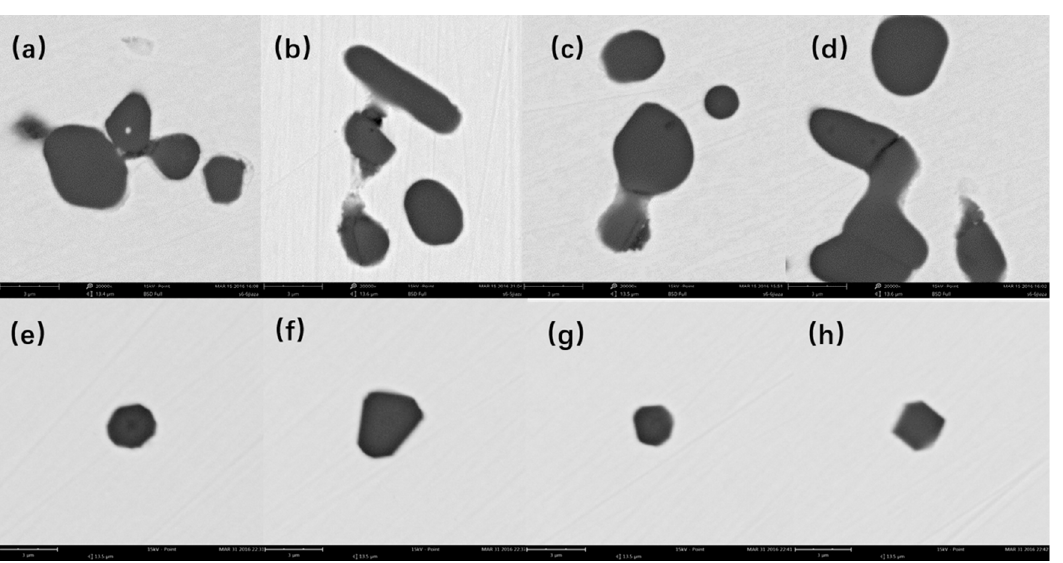
Figure 2. Morphologies of typical inclusions in samples by SEM: Al 2 O 3 (( a ), ( b ), ( c ), ( d )); MgAl 2 O 4 (( e ), ( f ), ( g ), ( h )).